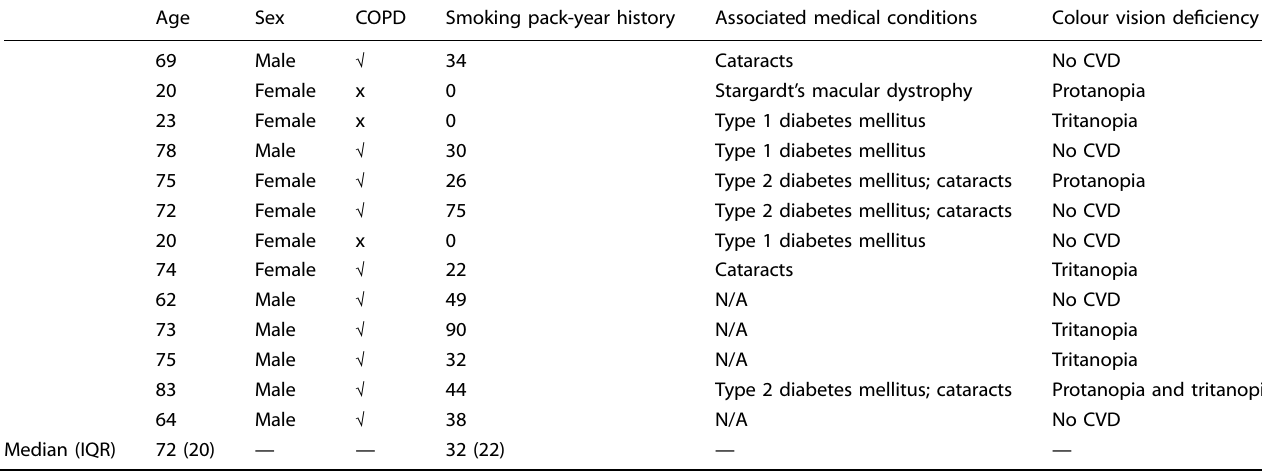
Table 3. Characteristics of the participants assessed for undiagnosed colour vision de fi ciency (CVD).